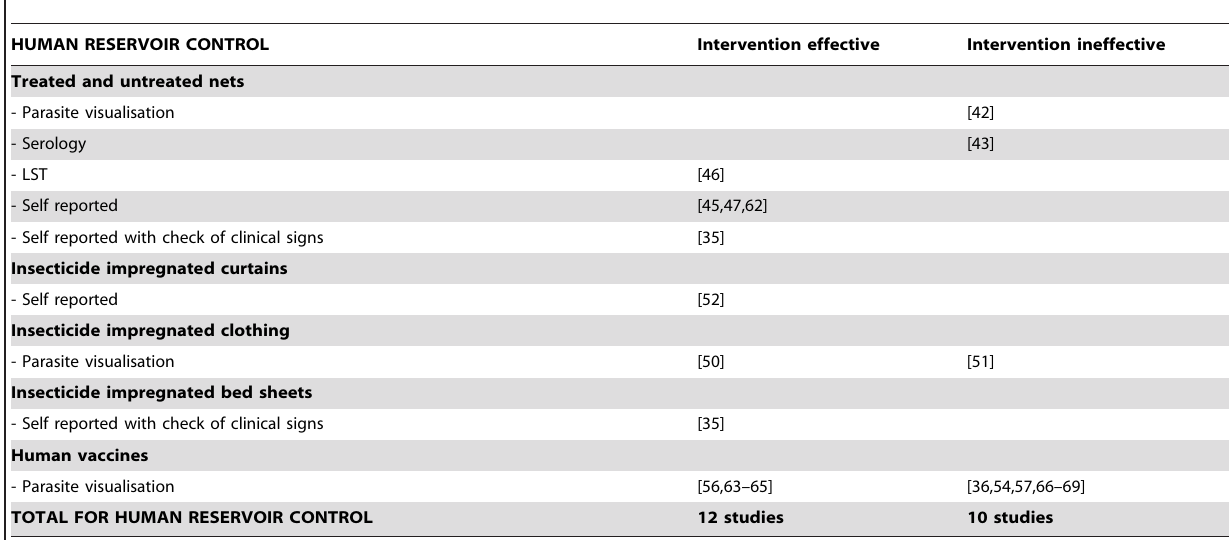
Table 3. Summary table of human outcome measurements for human reservoir control interventions.